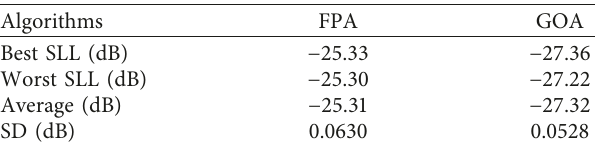
Table 5: The comparison of algorithms’ performance for 10-ele- ment linear array in 20 runs.